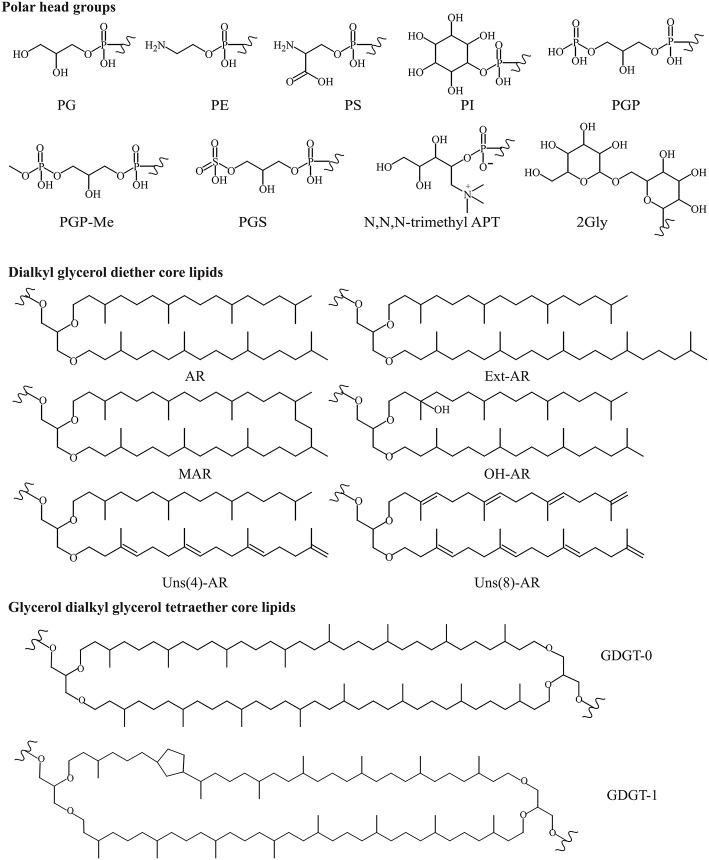
Structures of known polar headgroups and core lipids described in this study. Polar headgroups: PE, phosphatidylethanolamine; PS, phosphatidylserine; PI, phosphatidylinositol; PG, phosphatidylglycerol; PGP, phosphatidylglycerophosphate; PGP-Me, phosphatidylglycerophosphate methyl ester; PGS, phosphatidylglycerosulfate; trimethyl APT, N,N,N-trimethyl aminopentanetetrol (for other methylations see Figure 5); 2Gly, dihexose. Dialkyl glycerol diether core lipids; AR, archaeol; EXT-AR, extended archaeol; MAR, macrocyclic archaeol; OH-AR, hydroxy archaeol; Uns, unsaturated. Glycerol dialkyl glycerol tetraether core lipids (GDGTs, where n is the number of cyclopentane moieties).